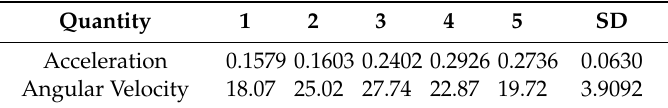
Table 2. The di ff erence between the two methods from 5 Table 2. The difference between the two methods from 5 trials.